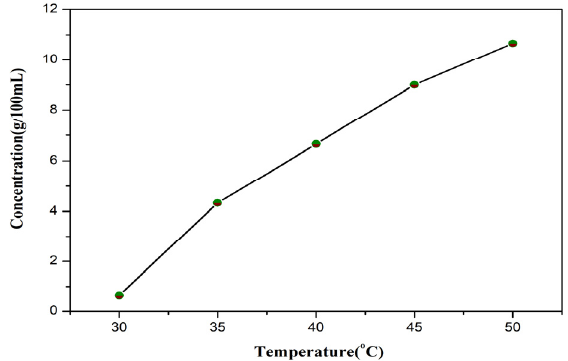
Figure 1. Solubility curve of MMPI.